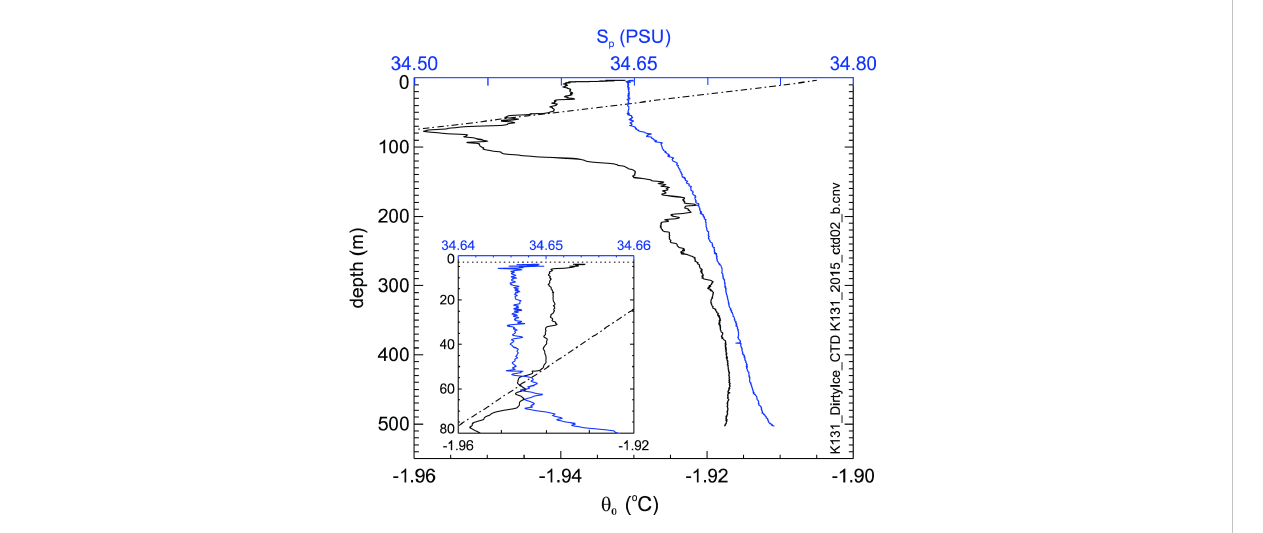
FIGURE 3 Example vertical pro fi les of temperature and salinity from the CTD, along with the in situ freezing temperature. The inset shows an expanded view of the upper 80 m. This pro fi le was from 0100 UTC on the 27 th of October 2015 (DOY 300). The dashed line shows the freezing point potential temperature referenced to surface